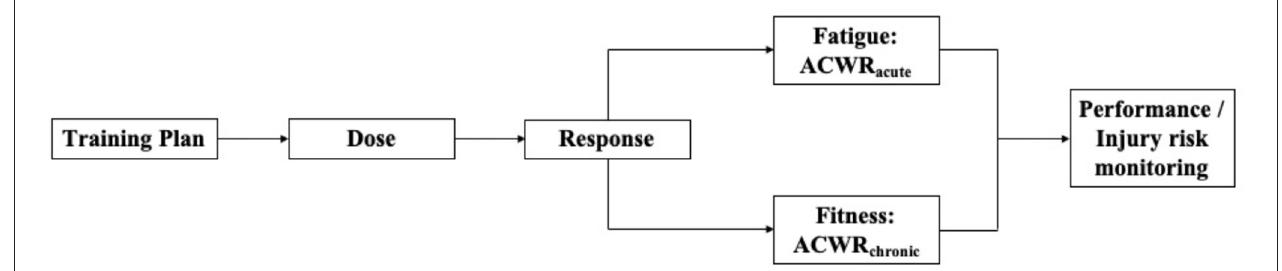
FIGURE 1 | Conceptual model for developing athlete monitoring systems according to the fitness-fatigue model using the acute: chronic workload (ACWR) approach and internal/external workload measures. While the fitness component is comparable to chronic workload (e.g., 28 days rolling average workload), fatigue is